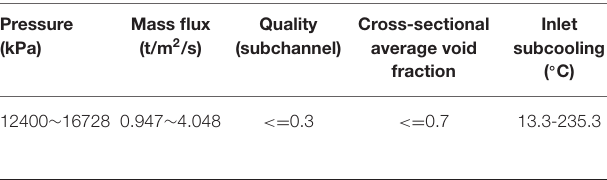
TABLE 1 | Range of CHF data selected in the assessment.